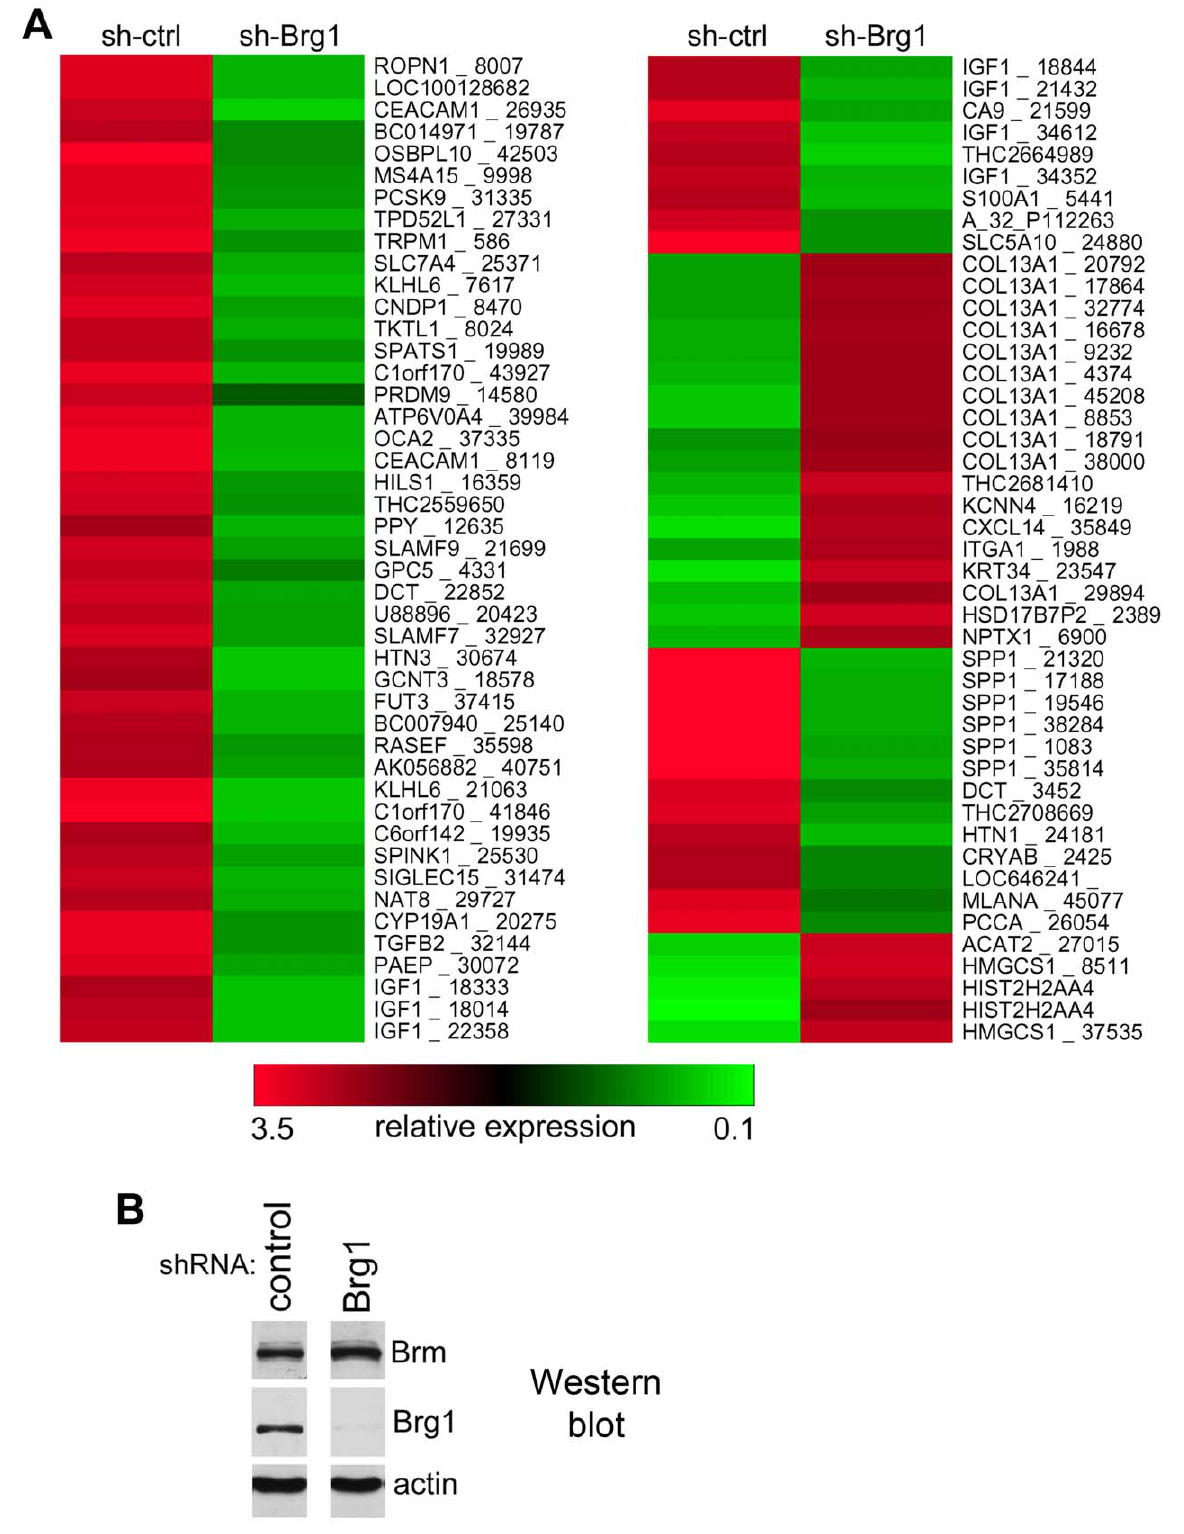
Figure 3. Microarrays showing transcriptional response of BRG1 knockdown in 501mel cells. A. Microarray analysis of genes that are differentially expressed between sh-control-transfected and sh-BRG1-transfected 501mel cells. Heat map shows only genes whose expression was changed more than 8-fold (P , 0.005). Color key (bottom, the highest expression is in red color) shows the relative range of expression. Genes the expression of which was down- or up-regulated . 2-fold (P , 0.005) are listed in Tables S1 and S3, respectively. Control and BRG1-shRNA transfected 501mel cells were analyzed immediately after a short (2-day) selection in puromycin to prevent cell death or reexpression of MITF due to the persisting BRM [26]. Two experiments (in duplicates) were carried out with similar results and one is presented. B. Western blot confirming the